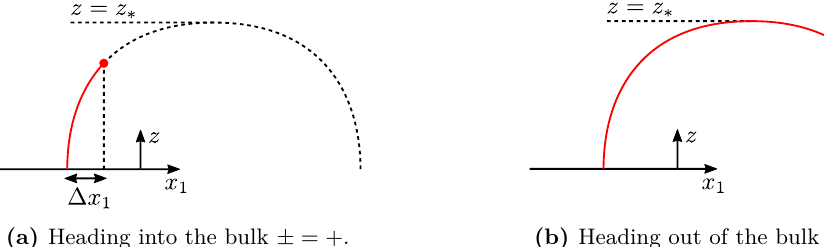
Figure 21. Definitions for the choice of ± in eq. (5.7) and for the corresponding ∆ x 1 ( > 0) from eq. (5.8) on the two branches of the RT